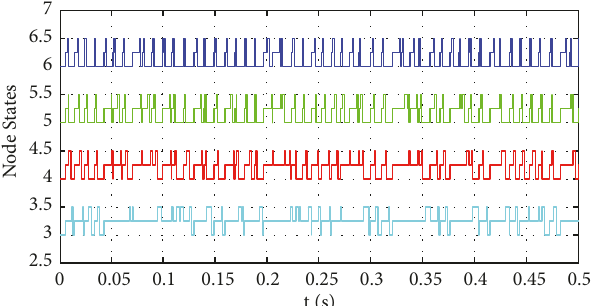
Figure 9: Network scheduling results ( T =0.008s, P